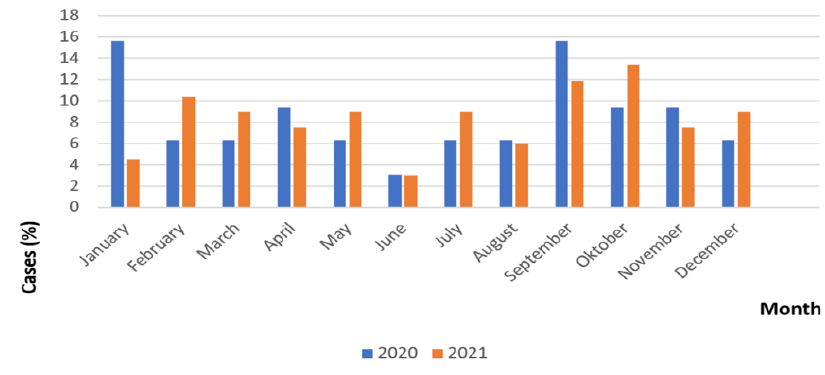
Figure 2. Frequency of new cases of T1DM during 2020–2021 by months.